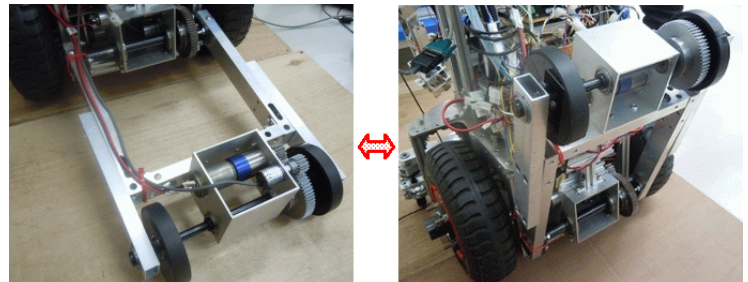
Figure 2. Robot rear wheel mechanism.